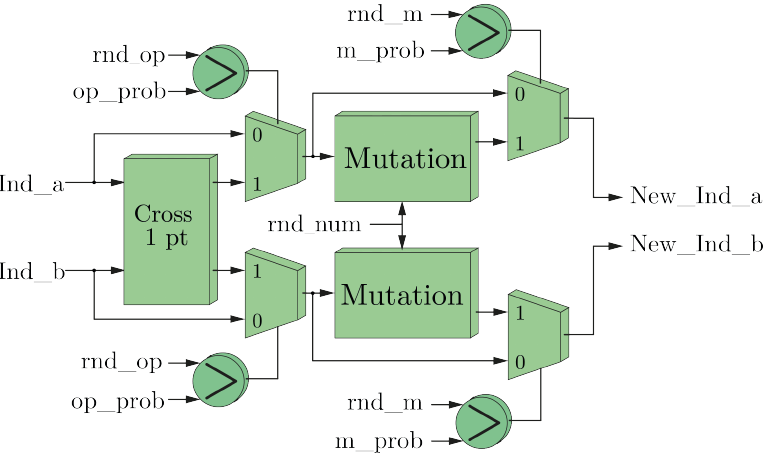
Figure 8. Block diagram for one-point crossover and mutation